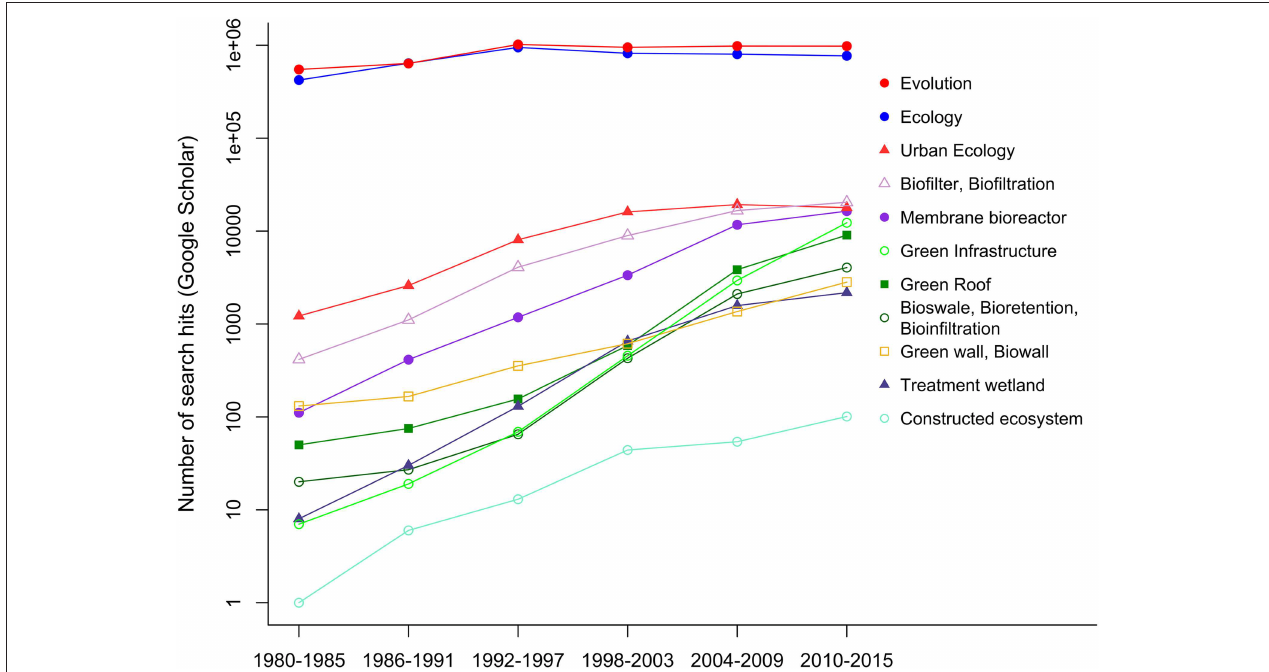
FIGURE 1 | Google Scholar search hits for terms related to green infrastructure and constructed ecosystems for 5 year